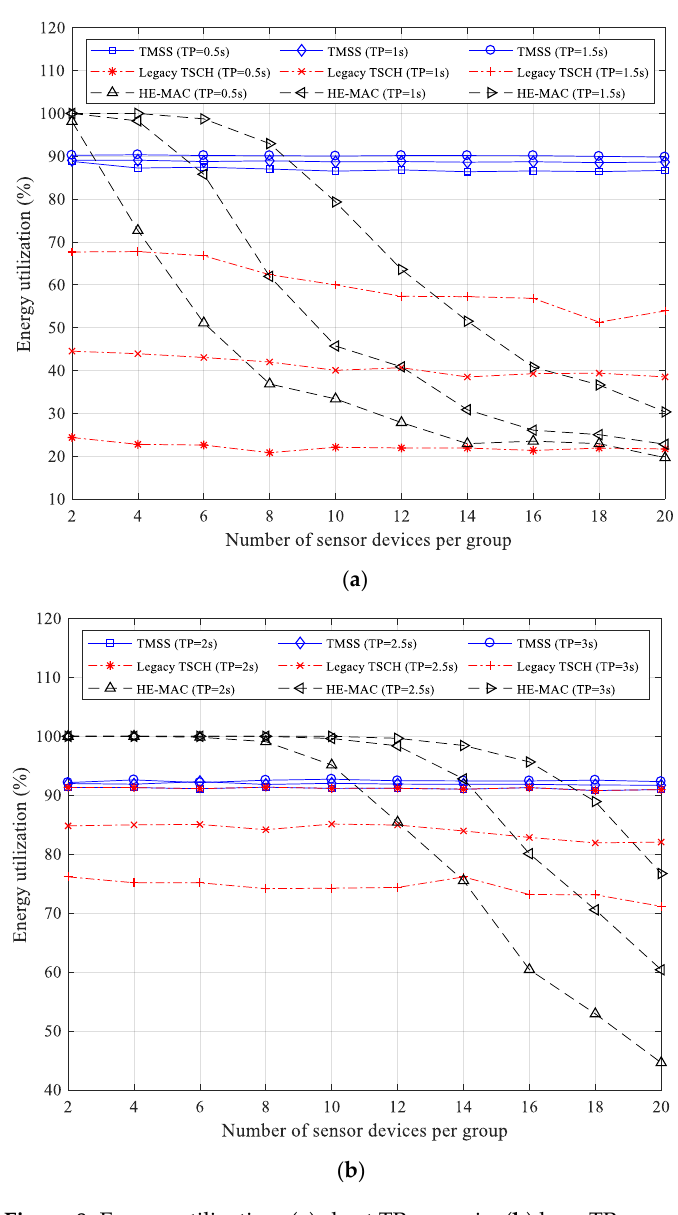
Figure 8. Energy utilization: ( a ) short TP scenario; ( b ) long TP scenario.